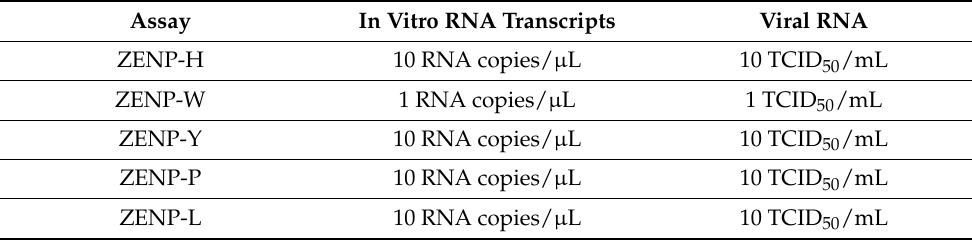
Table 4. Summary and comparison of potential detection limits for EBOV specific real-time one-step RT-PCR assays reported as in vitro RNA transcripts per microliter and 50% tissue culture infectious dose per milliliter (TCID 50 /mL). Assay In Vitro RNA Transcripts Viral